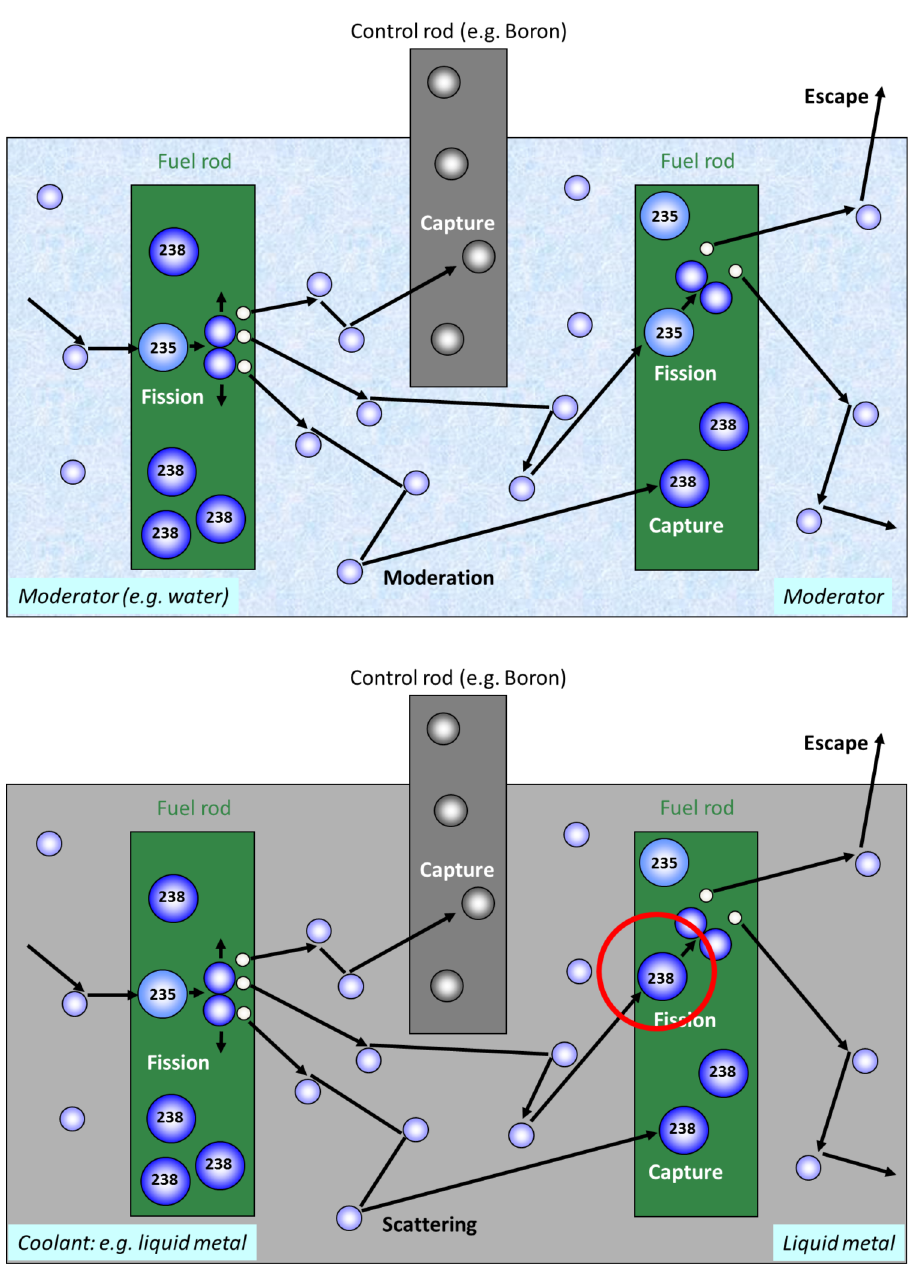
Fig. 5. – Conceptual schemes of thermal (top) and fast reactor (bottom). In the thermal reactor (top), the neutron energy spectrum exhibits a strong slow component from neutrons in thermal equilibrium with the moderator, with a kinetic energy of 25 meV at 290 K, corresponding to the most probable speed of the Maxwellian distribution. In the fast reactor (bottom), the neutron energy spectrum is much harder and most neutrons can have kinetic energies up to a few